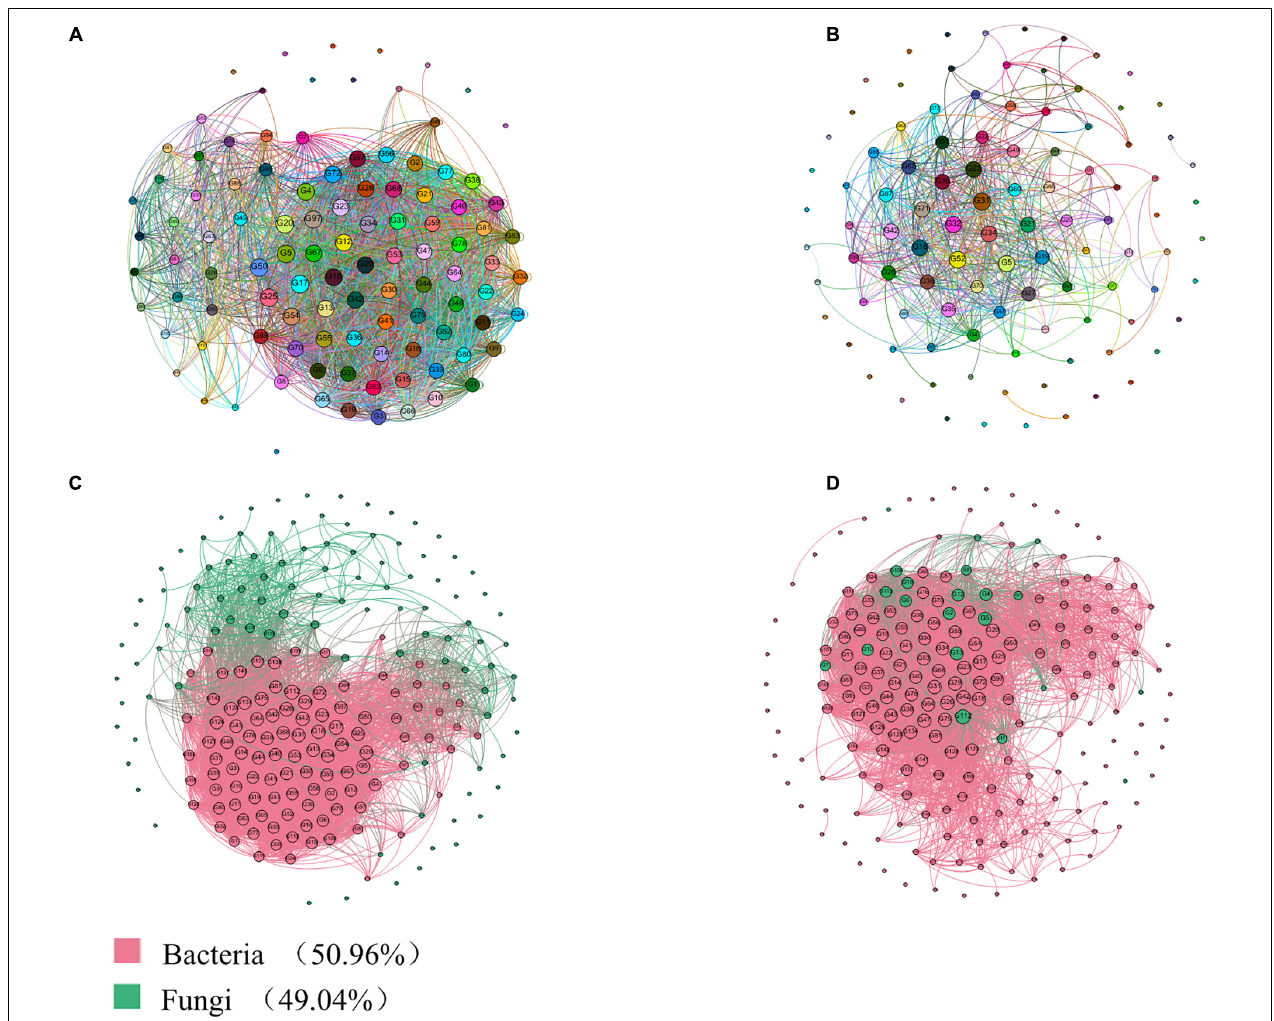
FIGURE 6 | Correlation network analysis of the rhizosphere and endosphere microbiomes in Gossypium sp. based on genus level. (A) Interaction analysis of bacteria; (B) Interaction analysis of fungi. (C) Interaction analysis of bacteria and fungi; (D) Interaction analysis of core microbiota-common microbiota. The size of each node is proportional to the